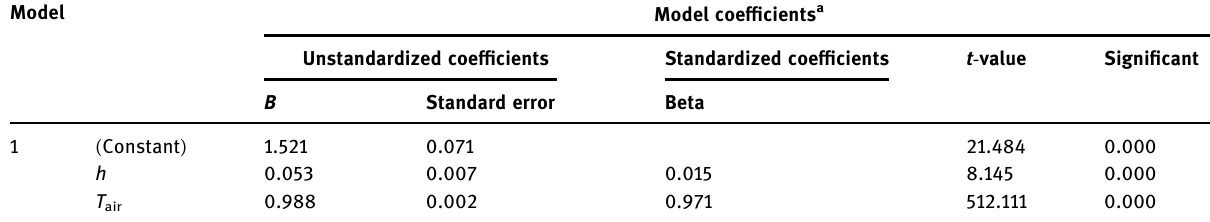
Table 7: Regression of developed